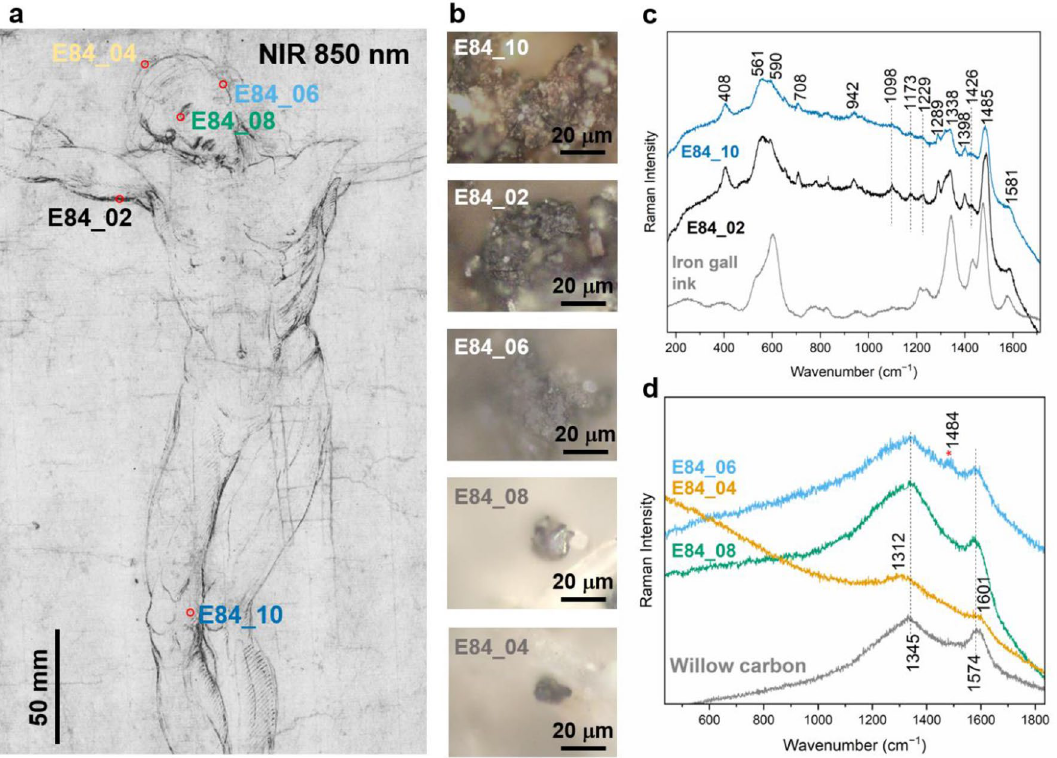
Figure 5. ( a ) Detail of the drawing centered at 850 nm with the measurement points; ( b ) microphotographs of the analysed points; ( c ) μ-Raman spectra of iron-gall ink identified in different points and compared to the reference, ( d ) μ-Raman spectra of identified carbon-based materials compared to the reference (the weak band from iron-gall ink is marked with *).